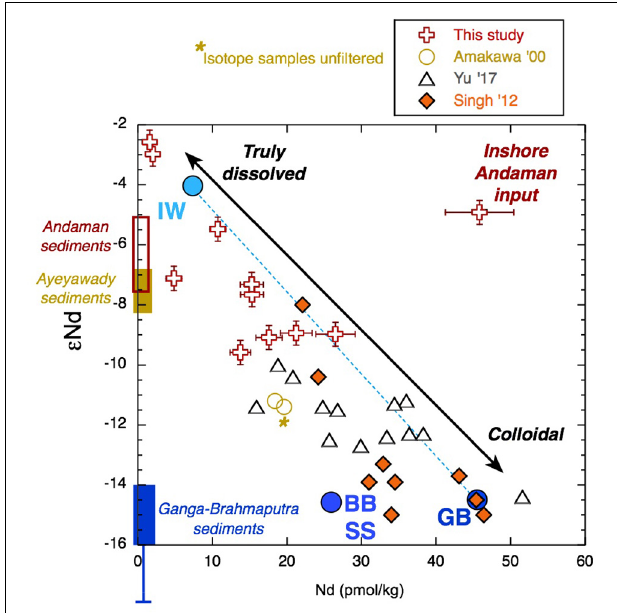
FIGURE 9 | Radiogenic Nd isotope composition vs. Nd concentration for all large volume samples of this study together with values from the literature (Amakawa et al., 2000; Singh et al., 2012; Yu et al., 2017a,b) for samples from the upper 50-m water depth of the Bay of Bengal (BoB) and Andaman Sea (AnS) ( Figure 1 ). Together, these data (excluding sample AN12) give a correlation coefficient value of r 2 = 0.75. AN12 is plotted as the “Inshore Andaman Input” sample. Sediment Nd isotope values from potential sources are shown along the y -axis for the Ayeyarwady (Irrawaddy) (Allen et al., 2008a; Giosan et al., 2018), for the Andaman Islands (Ali et al., 2015), and for the Ganga-Brahmaputra (Singh and France-Lanord, 2002 and the references therein). Note the one Irrawaddy value from Colin et al. (1999), which has no location information, is less radiogenic than the other Ayeyarwady samples and is more similar to the Yangon or Sittaung rivers located nearby (Giosan et al., 2018). The mixing line between Indonesian throughflow waters (IW) with Ganga-Brahmaputra low salinity surface water (GB) employs the end members from Amakawa et al. (2000) and Singh et al. (2012). This cannot account for the lowest concentrations and most radiogenic samples (note that the IW endmember was not filtered for isotope analysis), and much of the data from the literature fall off the mixing line owing to lower Nd